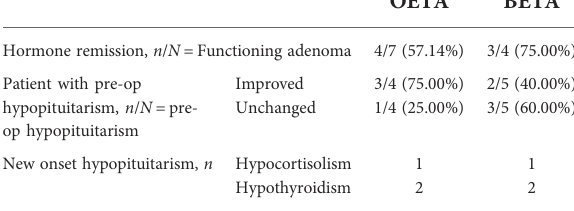
TABLE 2 Post-op endocrinal outcomes.